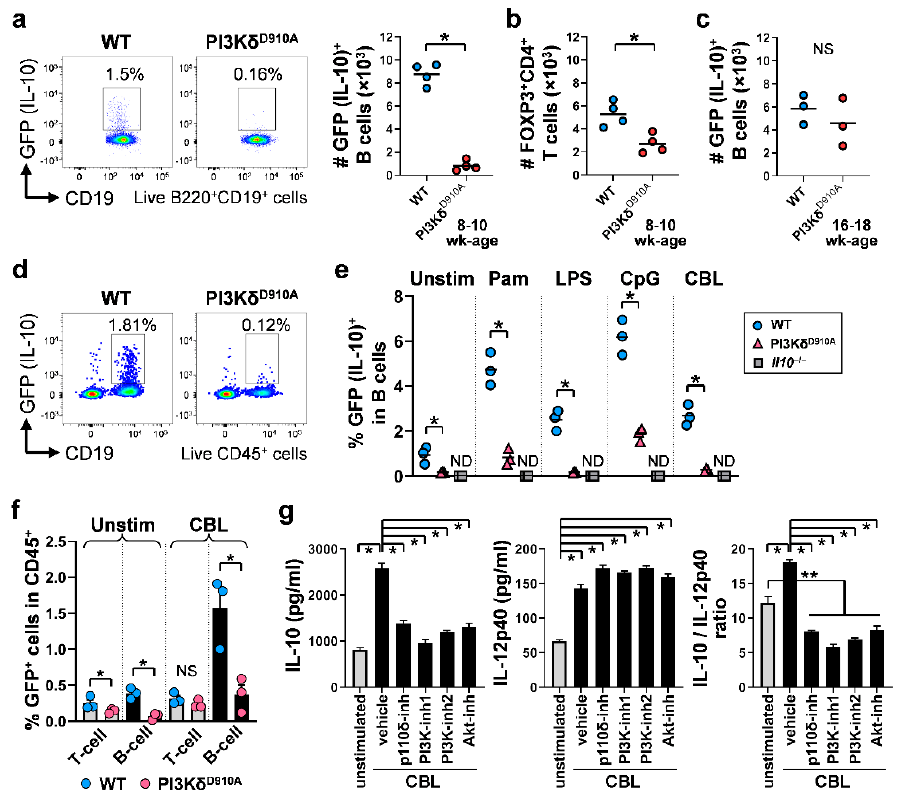
Figure 2. IL-10-producing B cells are significantly decreased in the colon of PI3K δ D910A mice. ( a ) Representative dot plots and frequencies of GFP (IL-10) + cLP B cells (Live/Dead neg CD45 + B220 + CD19 + ) from 8–10-week-old normal PI3K δ (WT); Il10 eGFP mice or PI3K δ D910A ; Il10 eGFP mice. Cell numbers are presented per 1 × 10 6 live cLP cells (Live/Dead neg CD45 + ). ( b ) The abundance of cLP FOXP3 + CD4 + T cells (Live/Dead neg CD45 + TCR β + CD3 + CD4 + CD8 neg FOXP3 + ) is demonstrated from 8–12-week-old WT; Il10 eGFP , PI3K δ D910A or Il10 − / − mice. ( c ) GFP + B cells from 16–18-week-old WT; Il10 eGFP or PI3K δ D910A ; Il10 eGFP mice are shown. ( d – f ) 1 × 10 6 unfractionated MLN cells from 8–10-week-old WT; Il10 eGFP , PI3K δ D910A or Il10 − / − mice were cultured with medium alone (unstim), Pam3CSK4 (Pam, 100 ng/mL), lipopolysaccharide (LPS, 200 ng/mL), CpG-DNA (CpG, 500 nM) or CBL (10 µg/mL) in complete medium for 24 h at 37 °C with 5% CO 2 . Representative dot plots of MLN cells stimulated with CBL are shown in d . The percentages of GFP (IL-10) + in the total B cell population are shown in e . The percentages of GFP + T cells (CD45 + TCR β + CD3 + ) and B cells (CD45 + B220 + CD19 + ) in MLN cells (CD45 + ) stimulated with CBL are shown in f . ( g ) 5 × 10 6 cLP B cells magnetically isolated from WT mice were cultured with or without CBL (10 µg/mL) in the absence or presence of PI3K/Akt inhibitors or vehicle control as described in Figure 1 legend in complete medium for 24 h. IL-10 and IL-12p40 levels in supernatants were measured by ELISA and IL-10/IL-12p40 ratios were calculated. Each symbol represents the result from individual mice, and bars indicate the mean in a – c , and e . Mean ± SEM are shown in f , g . Mann–Whitney unpaired two-tailed test was used for a – c , e , one-tailed for f . Dunn's multiple comparisons test following one-way ANOVA was used for g . * p < 0.05, ** p < 0.01. ND indicates not detected. NS indicates not significant.